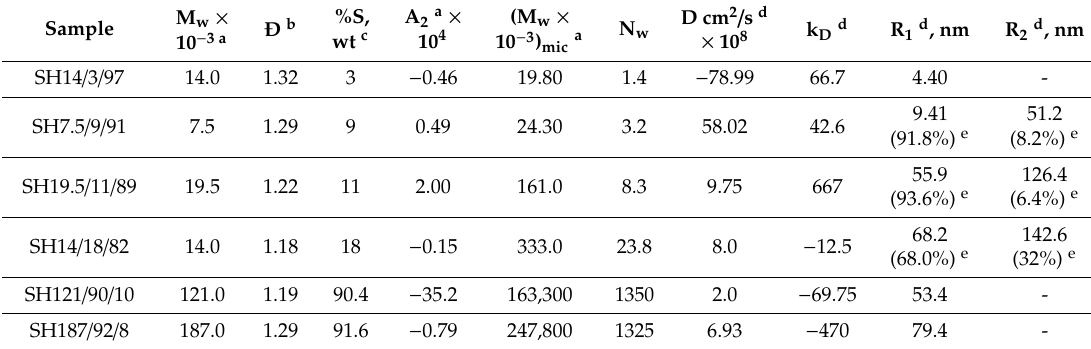
Table 1 H-NMR spectra were recorded in d-chloroform at 305.0 K with a Bruker Avance III 600 NMR spectrometer (Bruker, BioSpin, Rheinstetten, Germany). Table 1. Molecular characteristics of the SH block copolymers and their micellar characteristics in